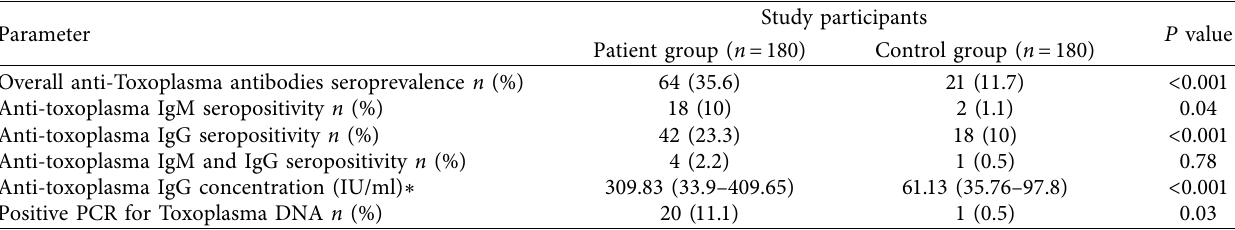
Table 1: Toxoplasmosis seroprevalence and molecular positivity rates among the patient group (children with neurodevelopmental disorders) and control group.